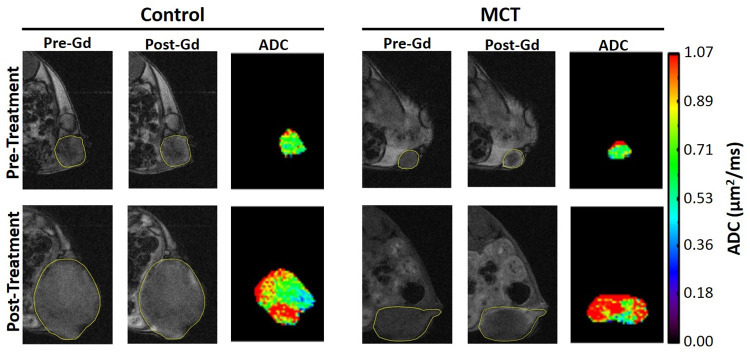
Pre-contrast and post-contrast DCE images and corresponding parametric ADC mappings of the central slice of 4T1 tumors for control and MCT mouse.An increase in ADC is seen with MCT tumors and confirms that there is a more geometrically favorable water environment with treatment. The yellow lines delineate tumor boundaries.